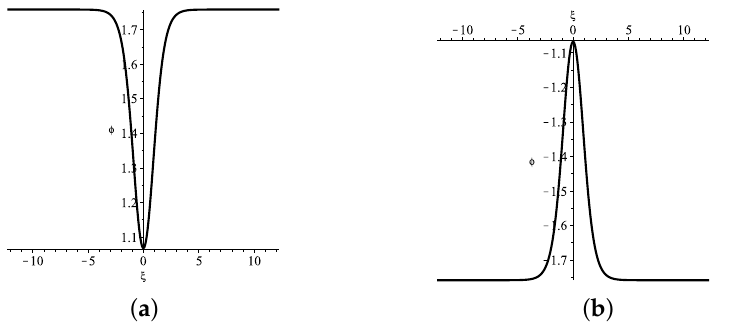
Figure 32. Solitary wave forms of system (5). ( a ) Dark solitary wave derived by (84) + . ( b ) Bright solitary wave derived by (84) −